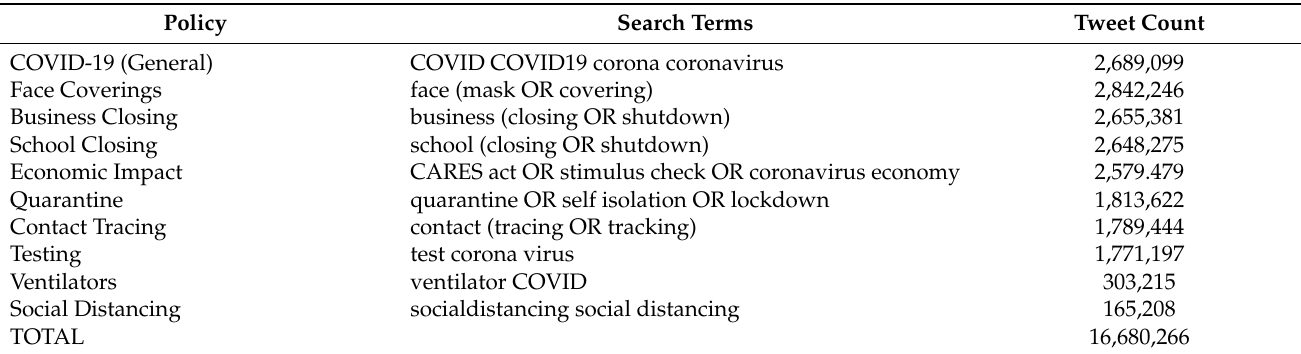
Table 1. Policy Names, Search Terms, and Tweet Counts (The counts are based on data collected between August 2020 and March